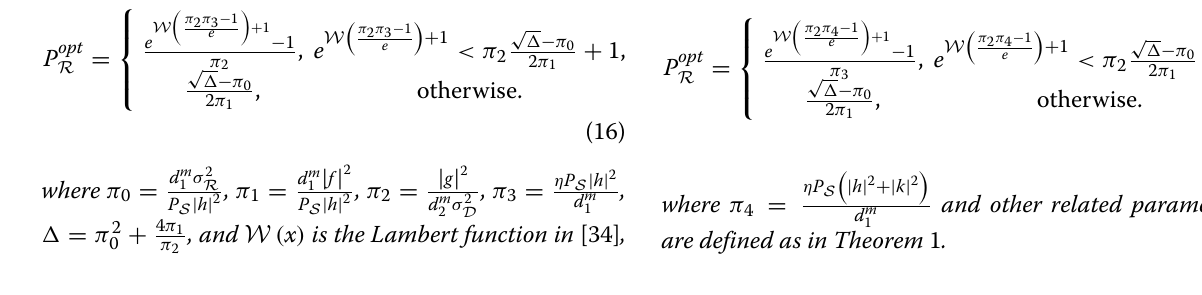
Table 3 CSI requirement for proposed TSAC protocol schemes EH